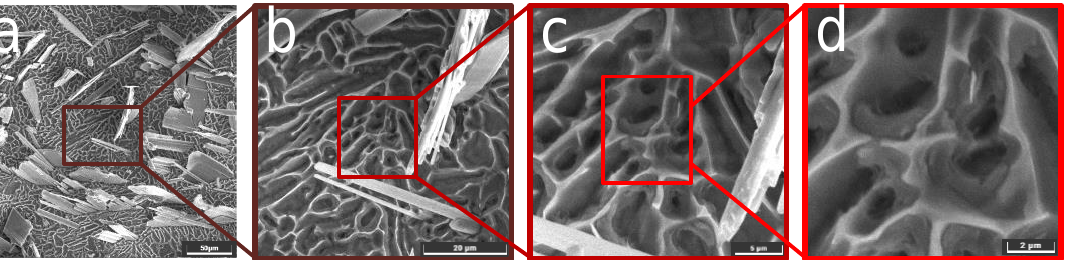
Figure 13. Higher-precision SEM images of 100 s dissolution processing time. ( a ) 500×, ( b ) 2000×, ( c ) 5000×, and ( d ) 10000×. The red box in each figure represents the zoomed-in part, resulting in the next figure.